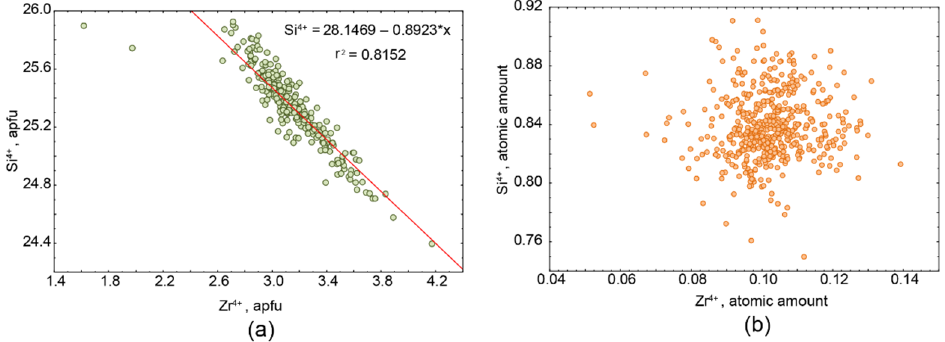
Figure 5. The relations between Si and Zr contents in EGM based on: ( a ) normalization scheme: Si + Al + Zr + Ti + Hf + Nb + Ta + W = 29 apfu, ( b ) atomic amounts.